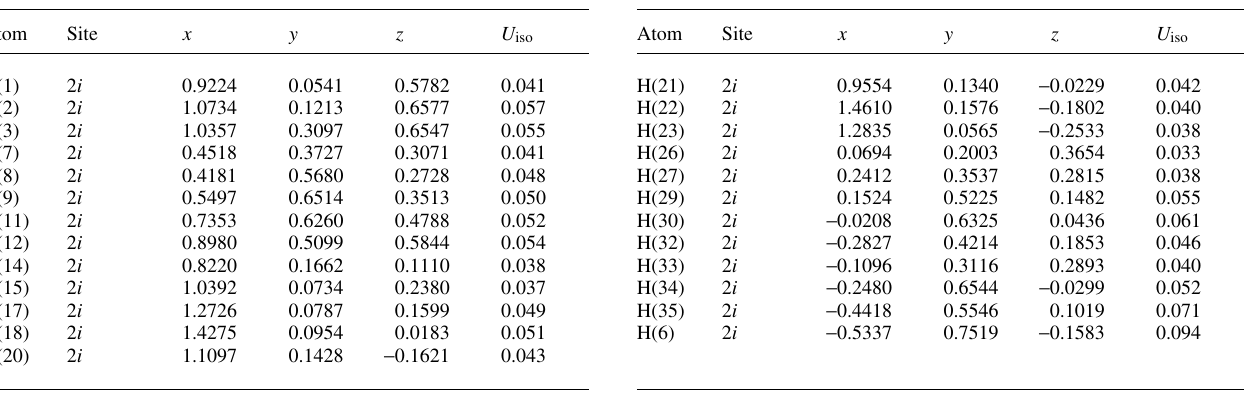
Table 2. Atomic coordinates and displacement parameters (in Å 2 )